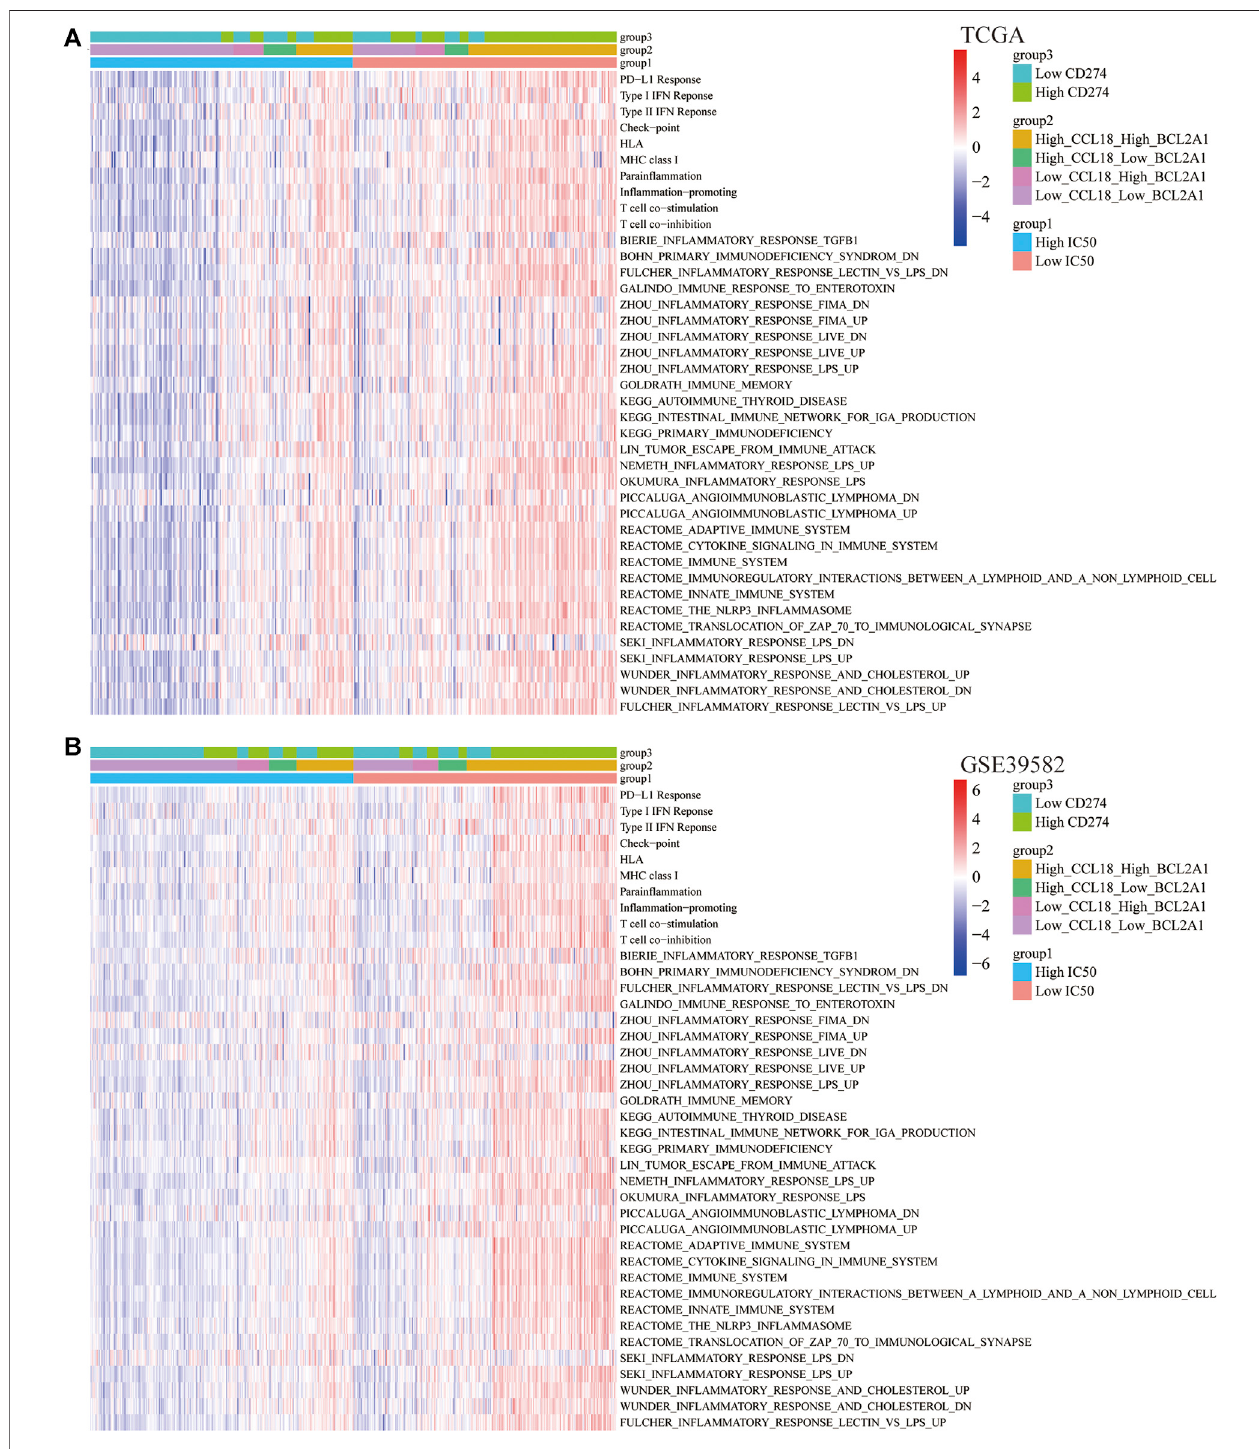
FIGURE 8 | Correlation of immune signatures and pathways. In (A) TCGA and (B) GSE39582, the score of most immune signatures and pathways were signi fi cantly higher in the low-IC50 group and High_CCL18_High_BCL2A1 group.